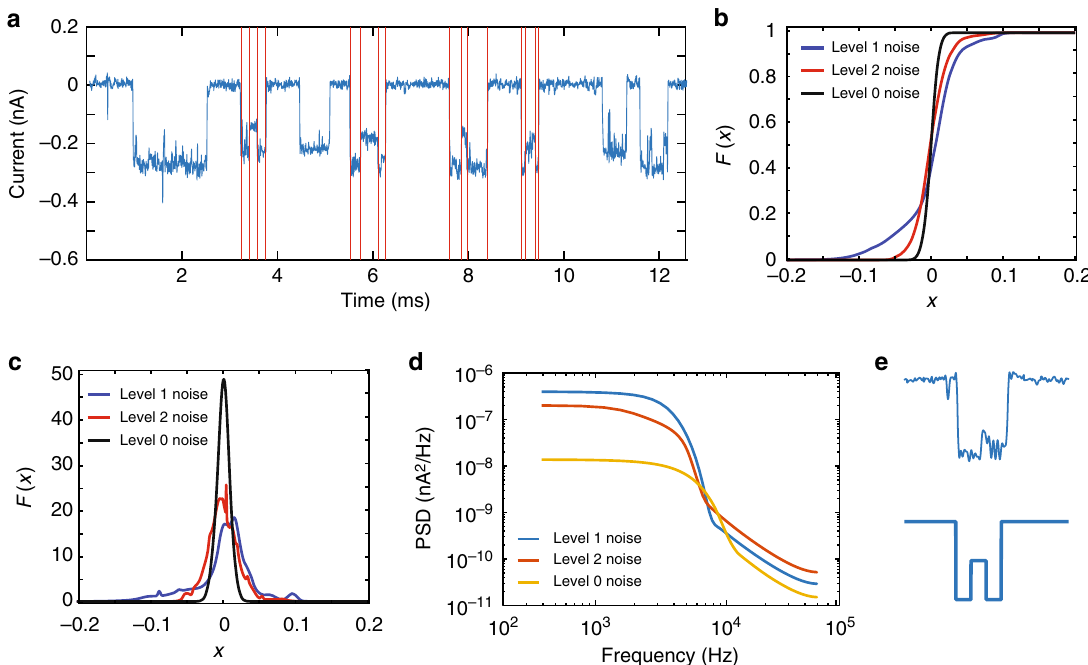
Fig. 3 a Typical curent trace, with current modulations induced by complexes translocating through a nanopore. Red lines indicate segments of Level 1 and Level 2 in the events. b Cumulative density functions (CDFs) of Level 0, Level 1, and Level 2 noise using a 4-component Guassian mixture model (GMM). c Probability density functions (PDFs) of Level 0, Level 1, and Level 2 noise using a 4-component Guassian mixture model (GMM). d Power spectral density (PSD) of Level 0, Level 1, and Level 2 noise using standard pwelch methods. e A sample “ 212 ” event, in which the Level 1 signal is hard to accurately discriminate without the noise spectrum analysis. Source data used to generate this fi gure can be found in the Source Data fi